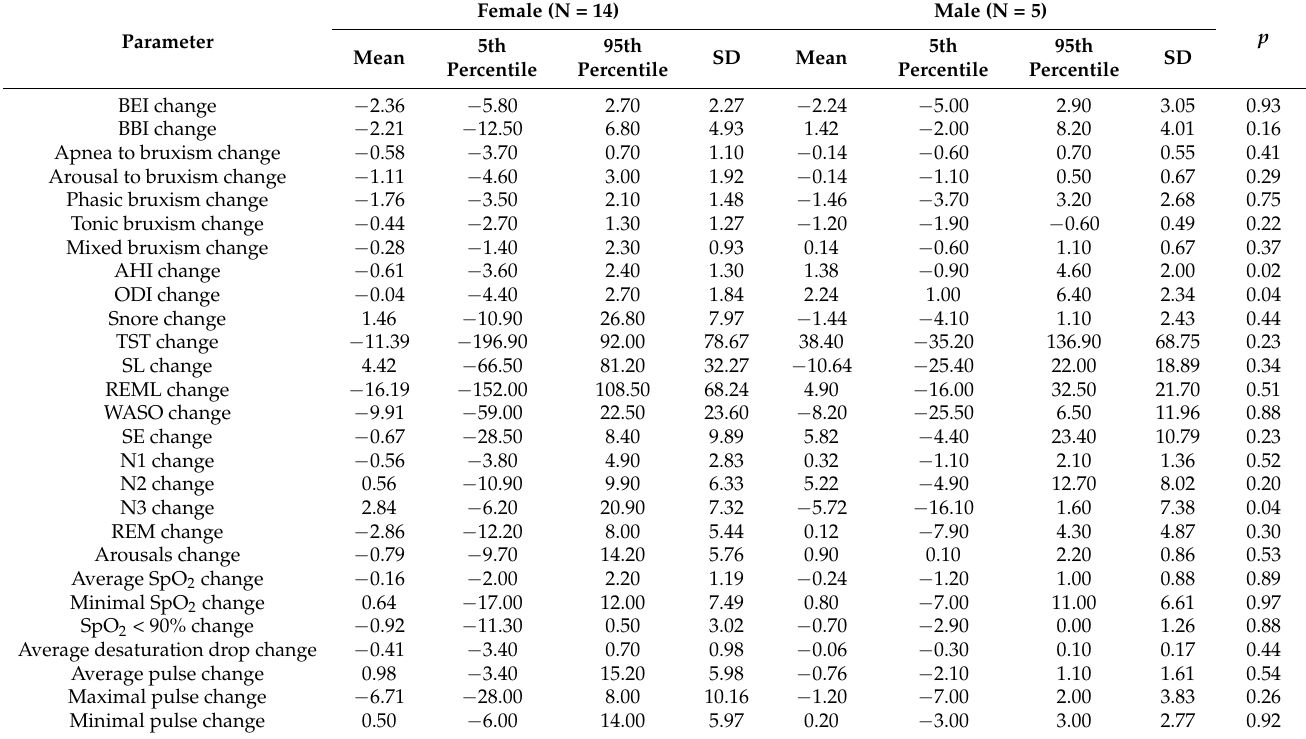
Table 5. Comparison of the change in the studied parameters between genders.